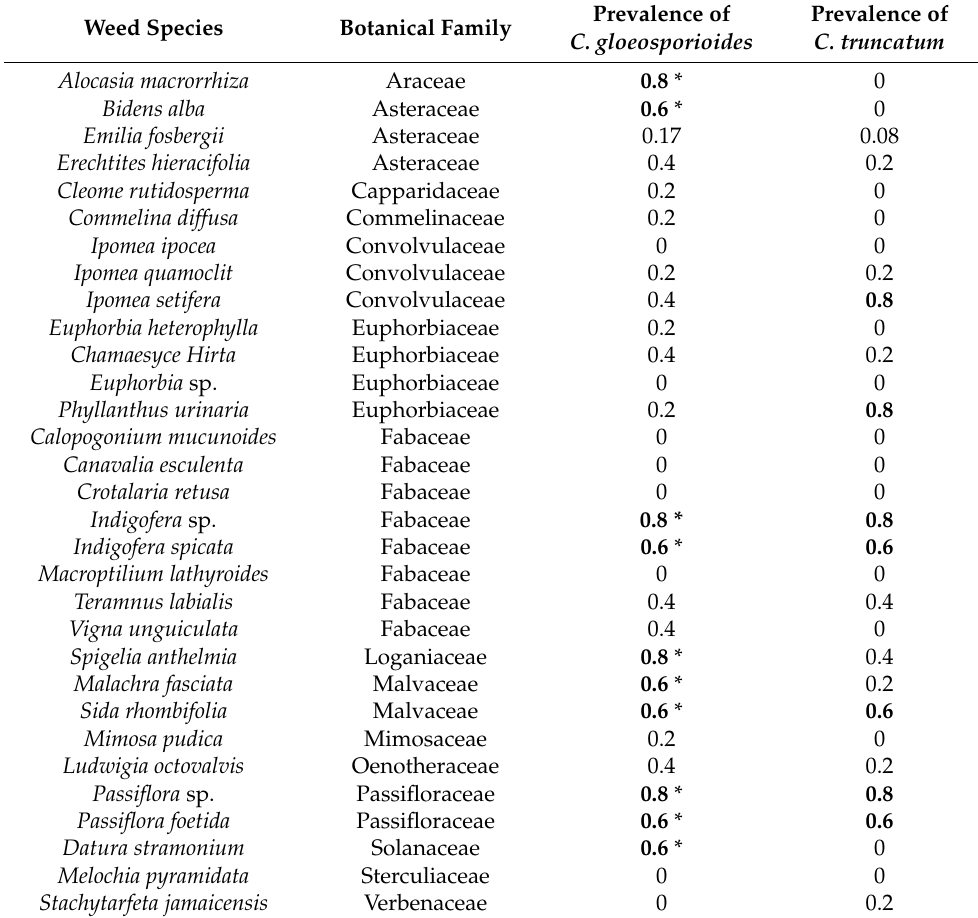
Table 1. Listings of common weed species from Guadeloupean Yam fields by botanical families and estimated prevalence of Colletotrichum gloeosporioides and C. truncatum on these weeds in four post-harvest